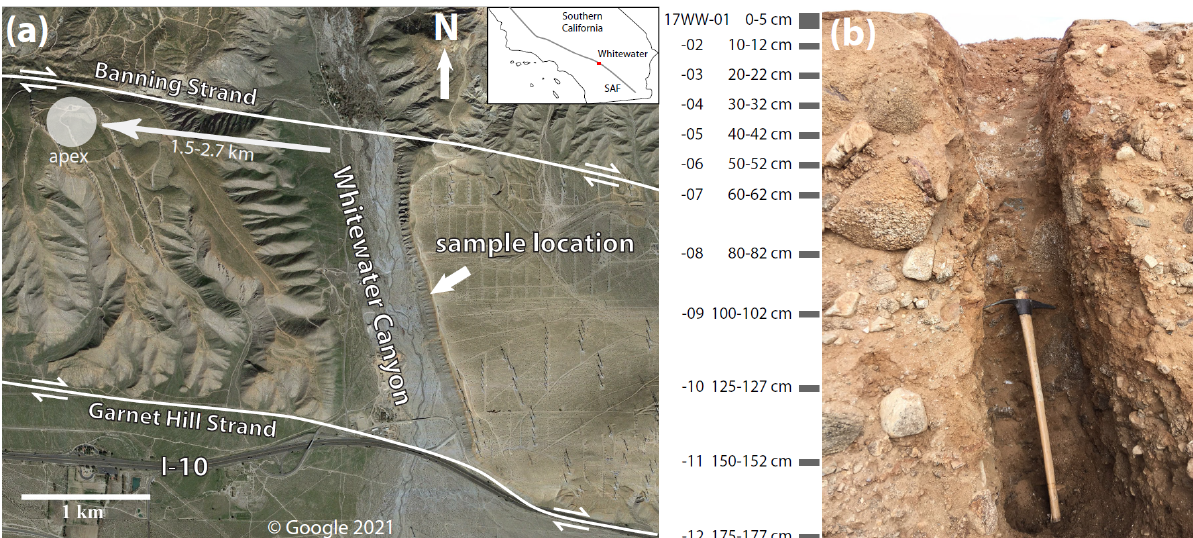
Figure 1. (a) Map of the offset alluvial fan complex at Whitewater, California, USA, which was offset from the mouth of the Whitewater River by the Banning strand of the San Andreas fault. The current location of the fan apex (Huerta, 2017) and the offset from the mouth of Whitewater Canyon are shown. (b) The relict soil capping the terrace was sampled from the surface to 1.77m of depth. Sample IDs are shown next to depth intervals. Magnetite was separated from these samples for microCT scanning and 3 He measurement. Aerial imagery taken from © Google Earth. Fault traces after Kendrick et al. (2015). Offset alluvial fan apex from Huerta